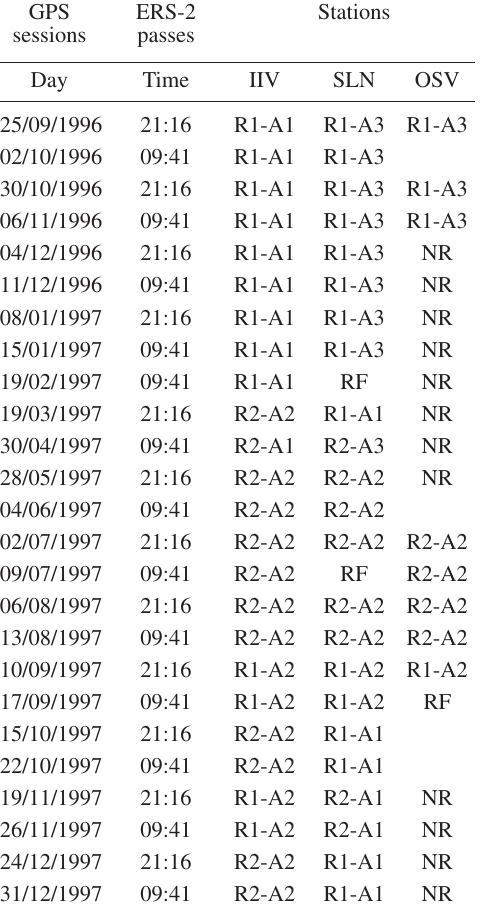
Table II. List of the GPS sessions and the SAR pass- es over Mt. Etna considered in this work. For ascend- ing passes, SAR satellite passes over Mt. Etna at 21:16, while for descending pass at 09:41 UTC. Each GPS session is 4 h long (from 19:16 to 23:16 UTC for ascending passes and from 07:41 to 11:41 UTC for descending ones). In the last four columns the codes describe the receivers and antenna used: R1 = Trimble 4000SSE; R2 = Trimble 4000SSI; R3 = Rogue SNR- 8100; A1 = 4000ST L 1/ L 2 Geodetic; A2 = Trimble L 1/ / L 2 Dorne Margolin element with chokerings; A3 = Geod. L 1/ L 2 compact, with groundplane; A4 = Dorne Margolin with chockerings. NR means that the site was unreachable, for instance due to snow cover prob- lems, and RF indicate Receiver Failures. Information on the NOTO, MATE and CAGL stations are available at <http://sopac.ucsd.edu>.